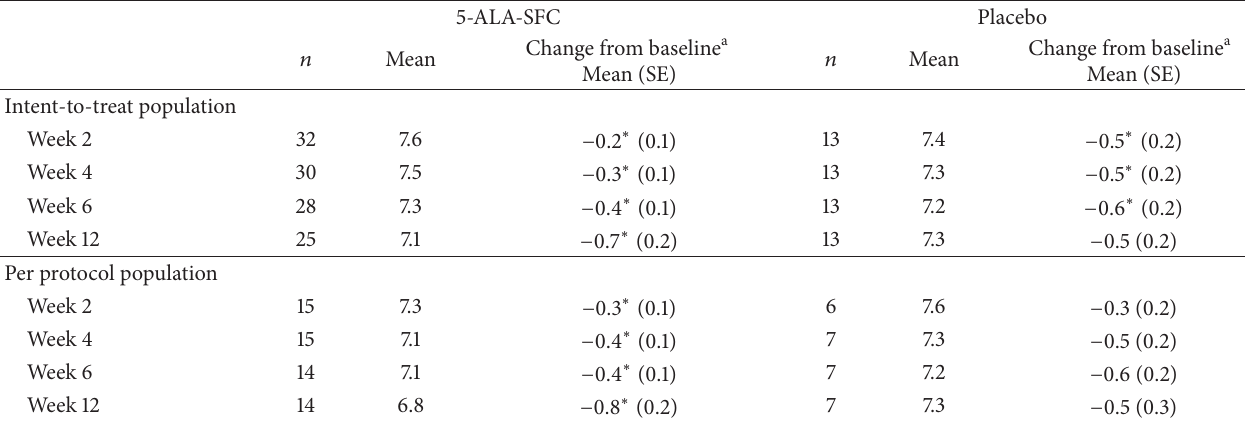
Table 5: Change in mean HbA1c during dosing period (ITT and PP